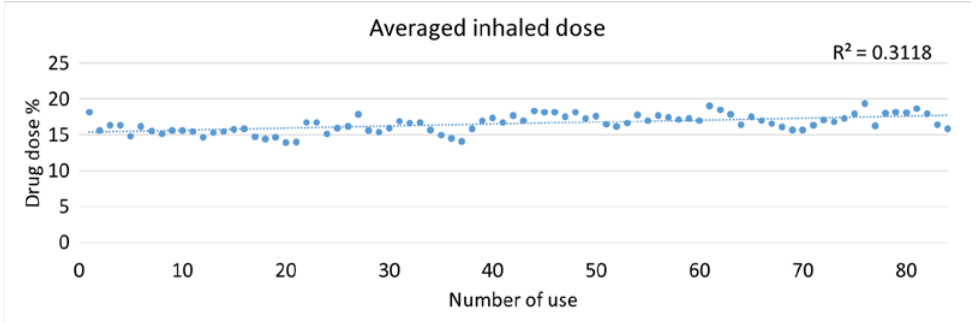
Figure 2. Averaged inhaled drug dose (%) over time ( n = 5).